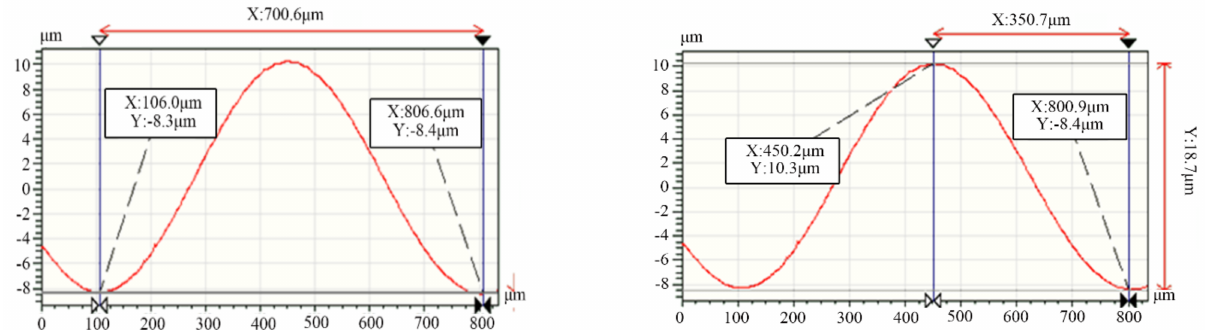
Figure 10. Two-dimensional profile of sinusoidal grid structures on a curved